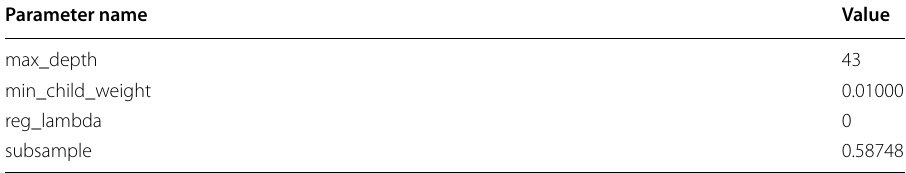
Table 62 Modes of XGBoost tuned hyperparameter values for experiments with the information theft dataset